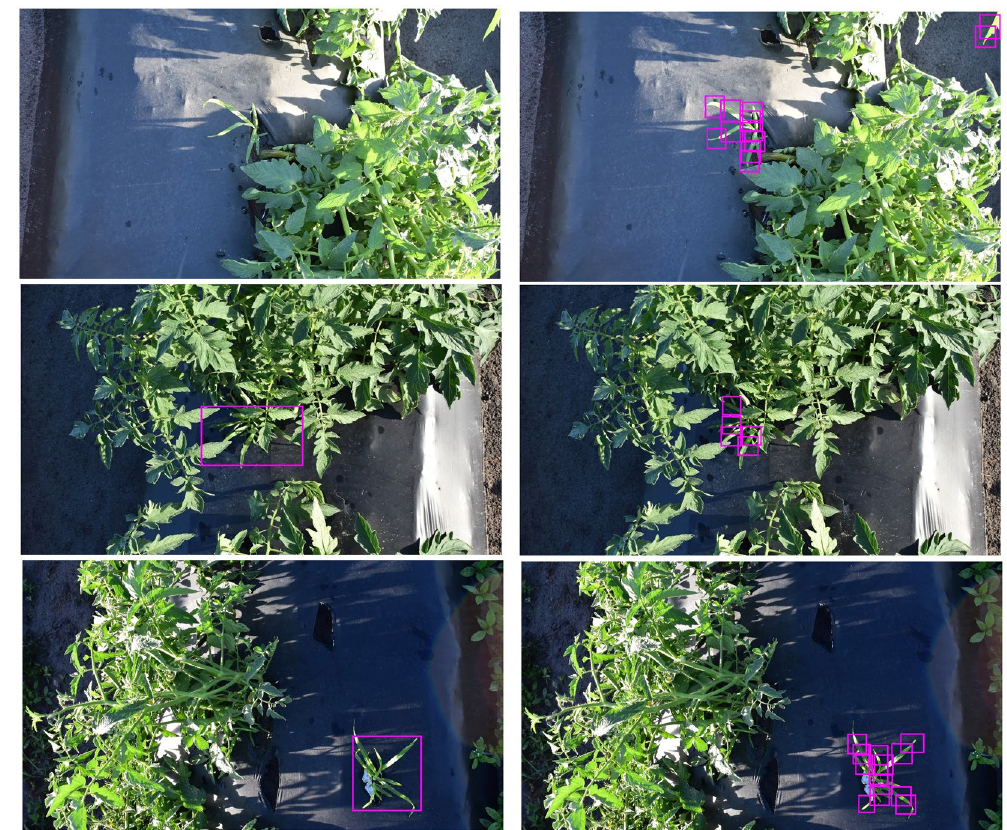
Figure 2. Examples of YOLOv3-tiny network detection of goosegrass ( Eleusine indica ) growing in competition with tomatoes ( Solanum lycopersicum ) using either entire plant (left) or leaf blade (right) annotation techniques in Balm, FL, USA in